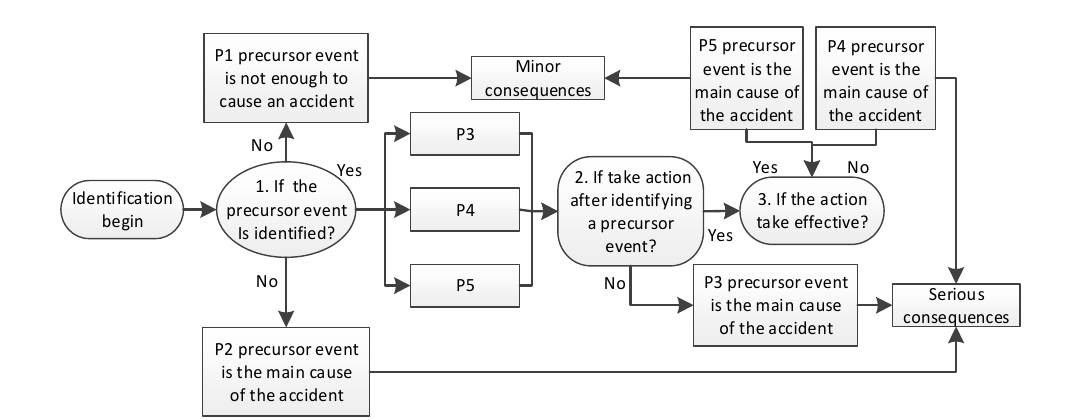
Figure 5. The roadmap for the management of precursors.